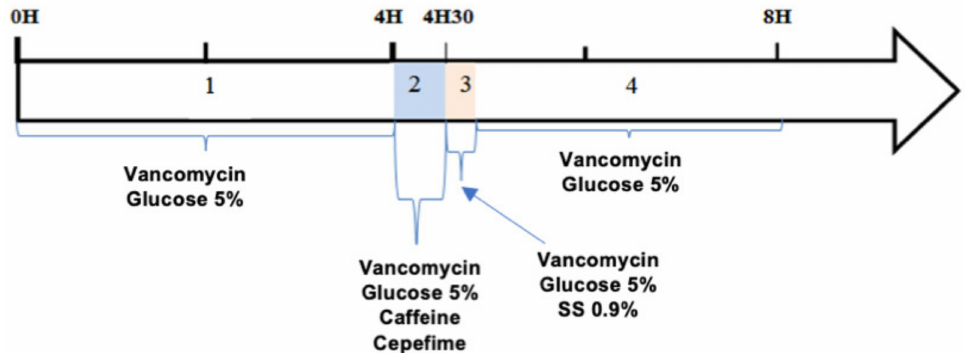
Figure 3. Infusion protocol adapted in vitro to the laboratory. 4 periods: (1) period T0 to T4H: Perfusion of vancomycin and G5%; (2) period T4H to T4H30: Perfusion of vancomycin, cefepime, caffeine and G5%; (3) T4H30-T4H41: Perfusion of vancomycin, G5% and rinsing with saline solution of the cefepime and caffeine routes; (4) period T4H41 to T8H: Perfusion of vancomycin and